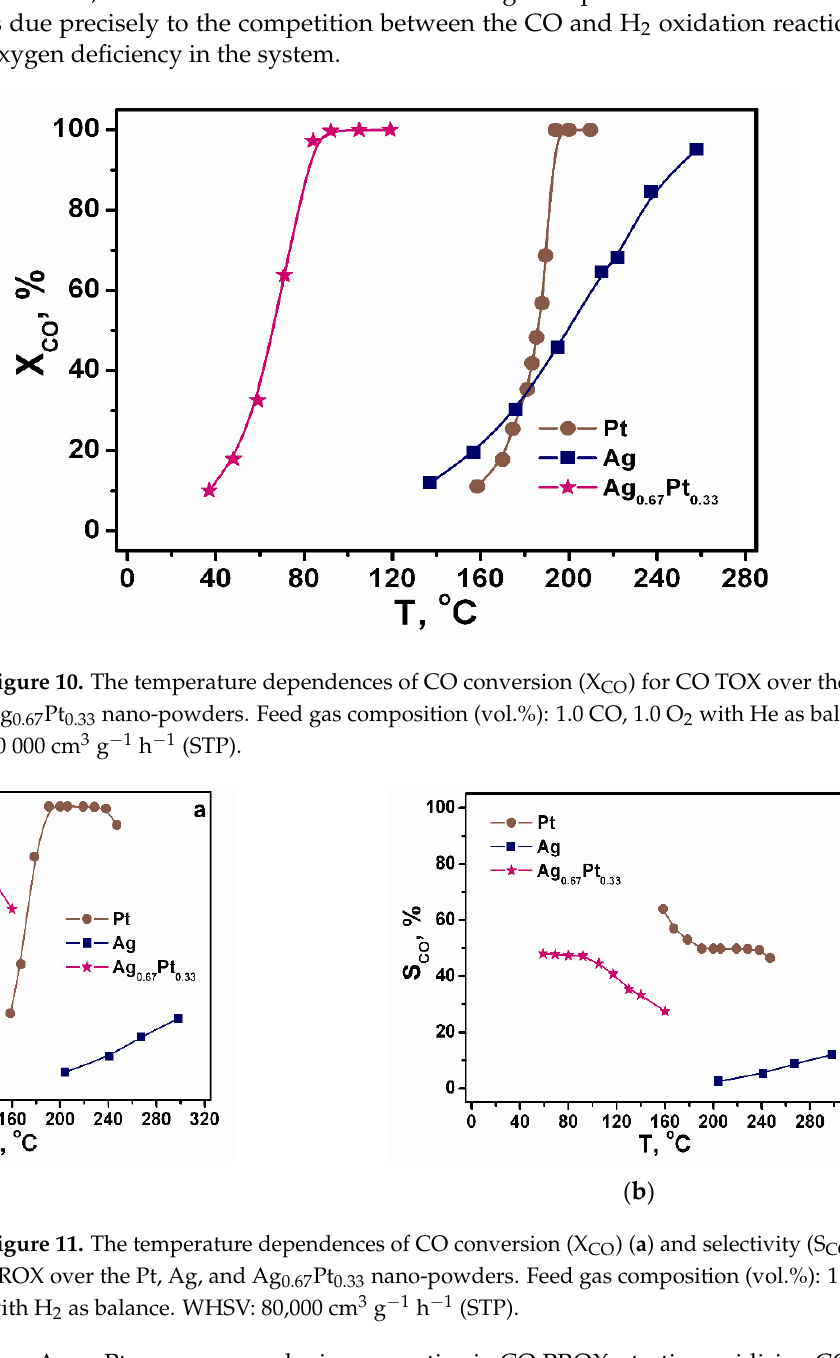
Figure 11. The temperature dependences of CO conversion (X CO ) ( a ) and selectivity (S CO ) ( b ) for CO PROX over the Pt, Ag, and Ag 0.67 Pt 0.33 nano-powders. Feed gas composition (vol.%): 1.0 CO, 1.0 O 2 with H 2 as balance. WHSV: 80 000 cm 3 g −1 h −1 (STP).